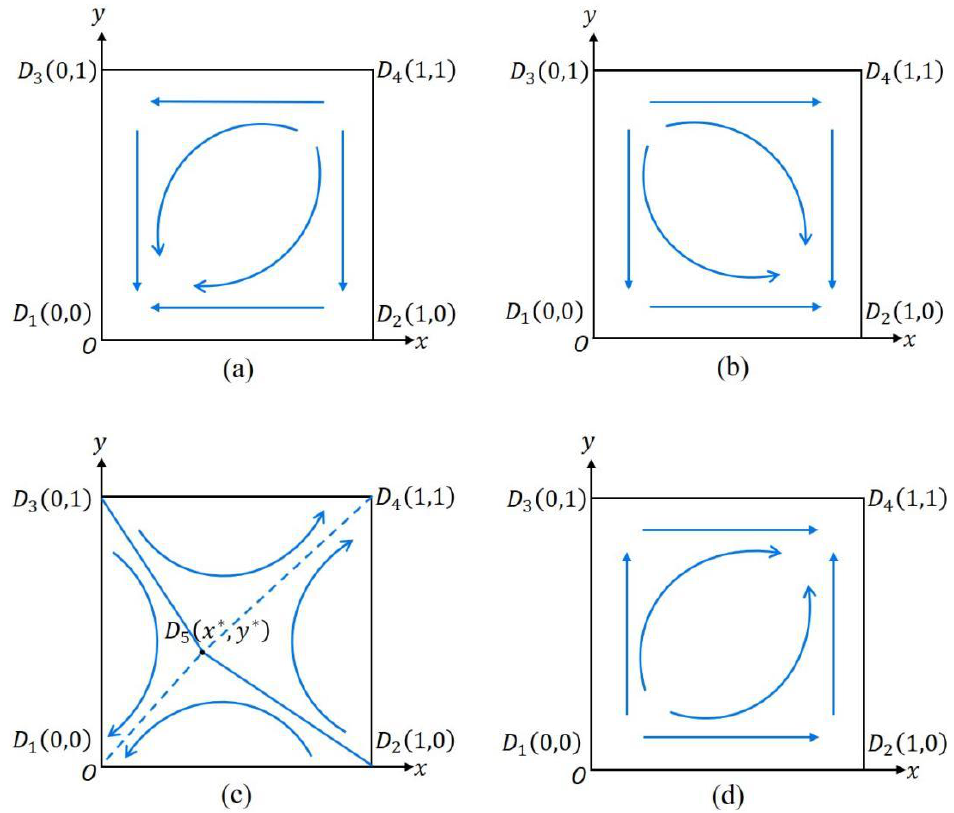
Figure 4. Evolutionary phase diagram between OHCs and users. ( a ) Evolutionary phase diagram of D 1 (0, 0); ( b ) Evolutionary phase diagram of D 2 (1, 0); ( c ) Evolutionary phase diagram of D 1 (0, 0) and D 4 (1, 1); ( d ) Evolutionary phase diagram of D 4 (1, 1).